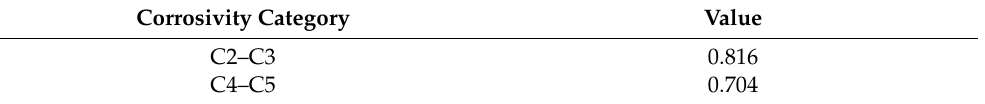
Table 6. Results obtained by Newton’s method for optimised b coefficient.